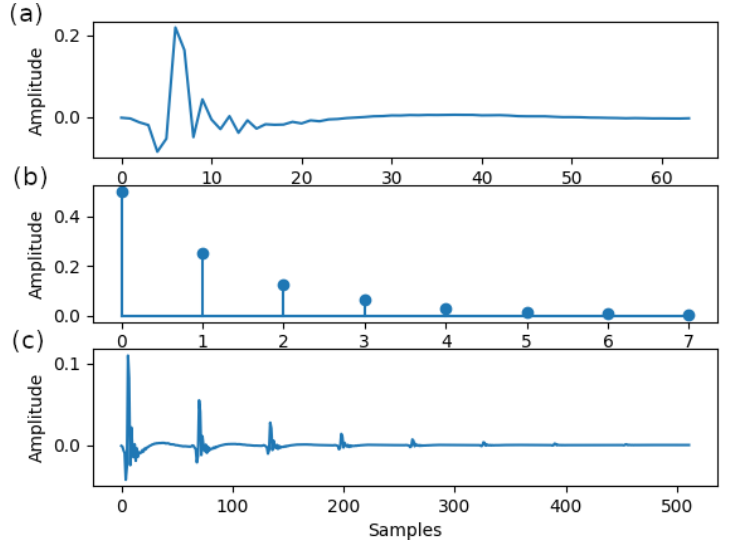
Figure 6. Impulse responses for the bilinear setup: ( a ) h 1 , first impulse from the G168 Recommen- dation [22]; ( b ) h 2 , exponential generated impulse response; and ( c ) impulse response of the target system, h = h 2 ⊗ h 1 .